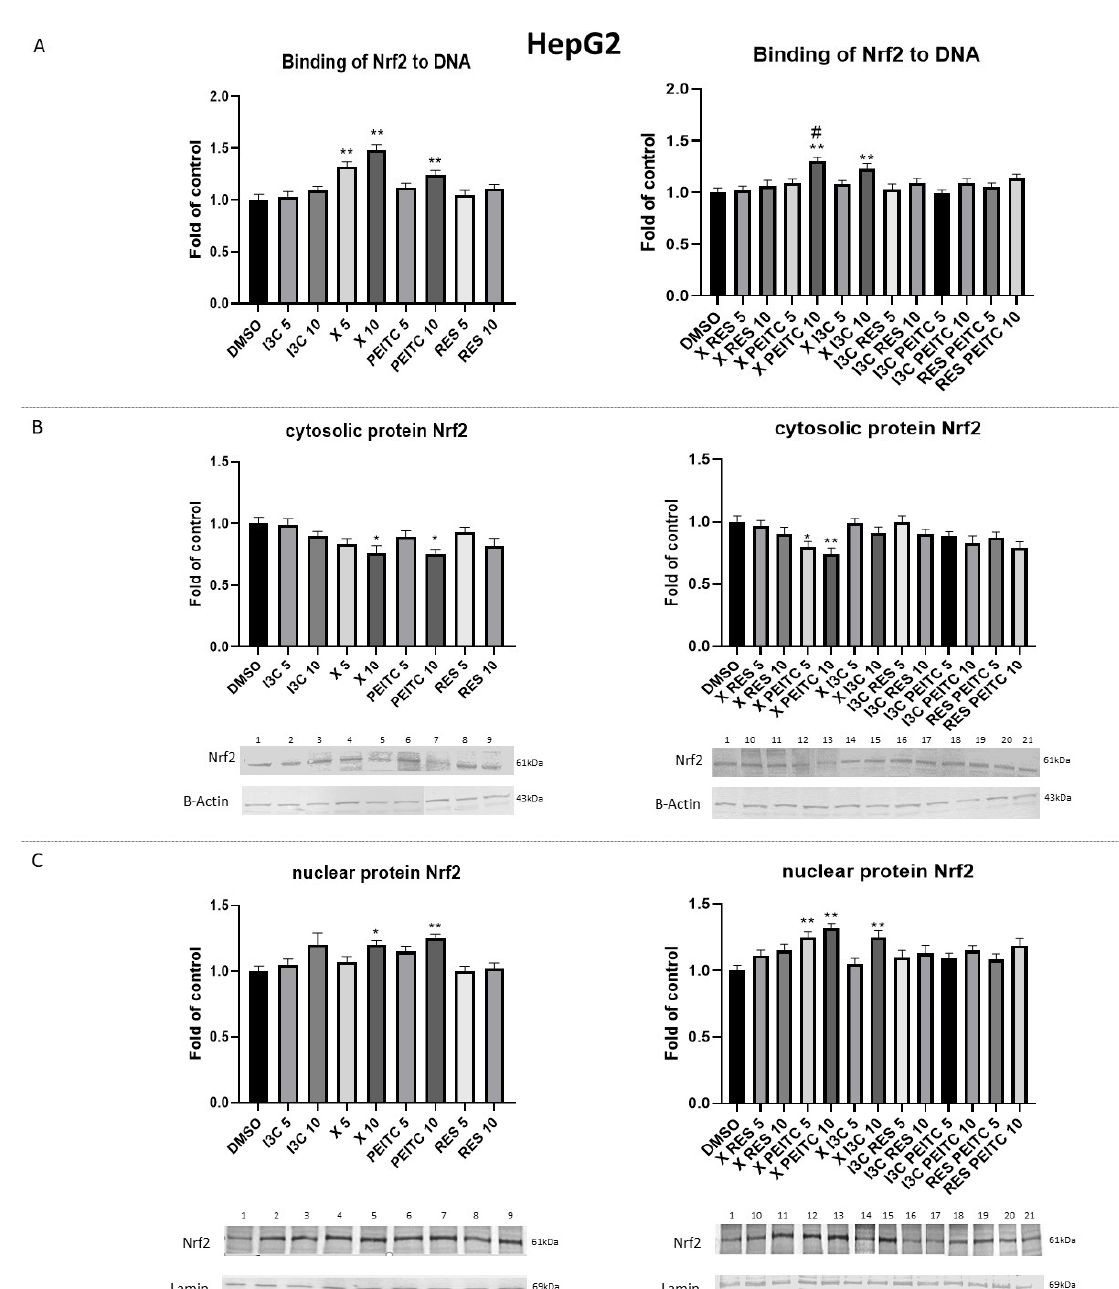
were used in calculations using CompuSyn software. Dose-effect curves for individual compounds (panel A ) or their combinations (panel B ) were generated. (Panel C ) The evaluation of the combination index (CI) for the assessment of the synergism (CI < 1; the area below the dotted line in plots) between chemicals. Fa–Fraction affected: viability reduction from lack of effect (0) to maximal effect (1; viability = 0%).